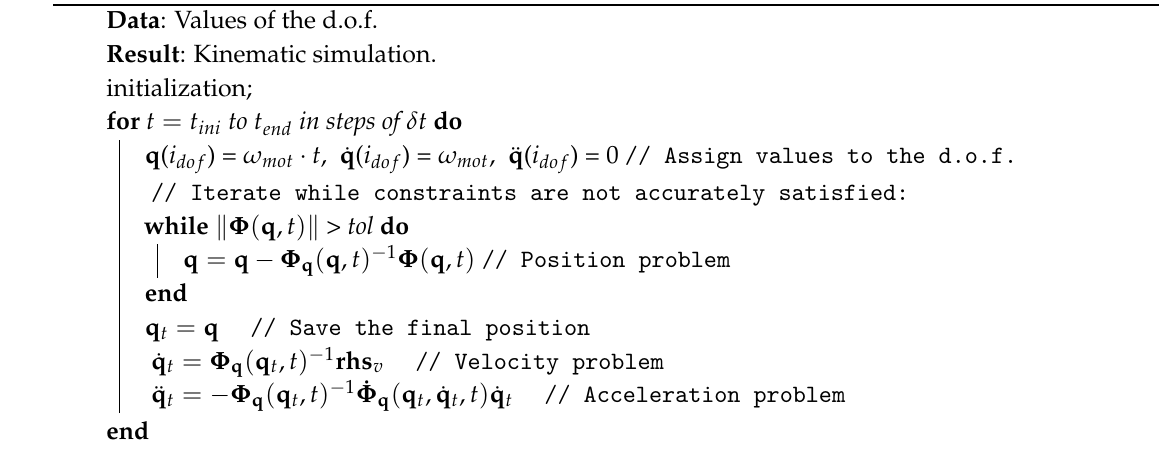
Algorithm 1: Kinematic Simulation for the Proposed Four-Bar Linkage Data : Values of the